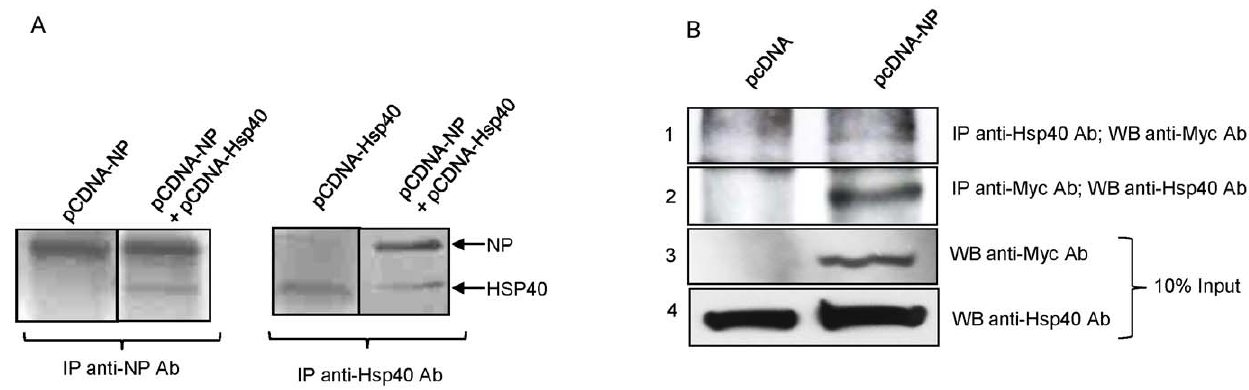
Figure 1. Detection of IAV NP-Hsp40 interaction in mammalian cells tranfected with NP expressing plasmid by co-immunoprecipitation. A. HEK293T cells were pcDNA3.1-NP and pcDNA3.1-Hsp40 plasmids alone or in combination, followed by metabolic labeling with S 35 . 48 hours post-transfection cells were harvested and IP was setup using anti-NP-specific antibody and anti-Hsp40-specific antibody followed by autoradiography. Lanes 2 and 4 show co-IP of Hsp40 with NP and vice-versa. Lanes 1 and 3 show anti-NP and anti-Hsp40 antibodies were not cross reacting with Hsp40 and NP, respectively. B. A549 cells were transfected with pcDNA3.1-NP plasmid or control pcDNA3.1 plasmid. Cells were harvested 48 hours post-transfection and immunoprecipitation was setup using anti-Myc tag antibody and anti-Hsp40 antibody, followed by western blotting. Lane 2 of panel 1 shows co-IP of NP with Hsp40 and lane 2 of panel 2 shows co-IP Hsp40 with NP. Lane 1 of panel 1 and 2 represents control samples transfected with empty vector. Panels 3 and 4 show expression levels of NP and Hsp40 in cell